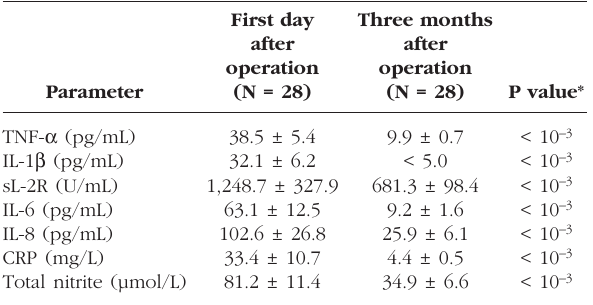
Table II. – Comparison serum cytokines, nitrate/nitrite and CRP levels (Mean ± SD) according to number of cysts.